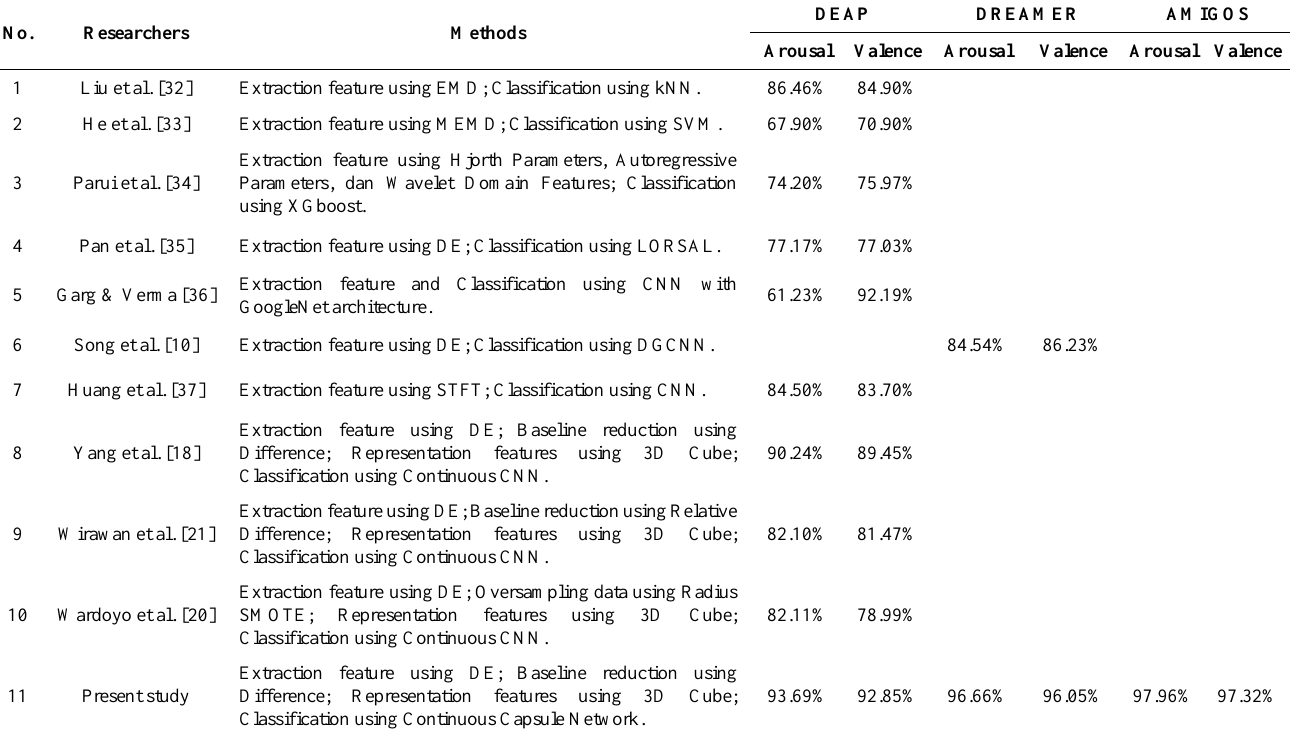
Table 11. Comparison of accuracy results between the proposed method and other methods for the two categories of